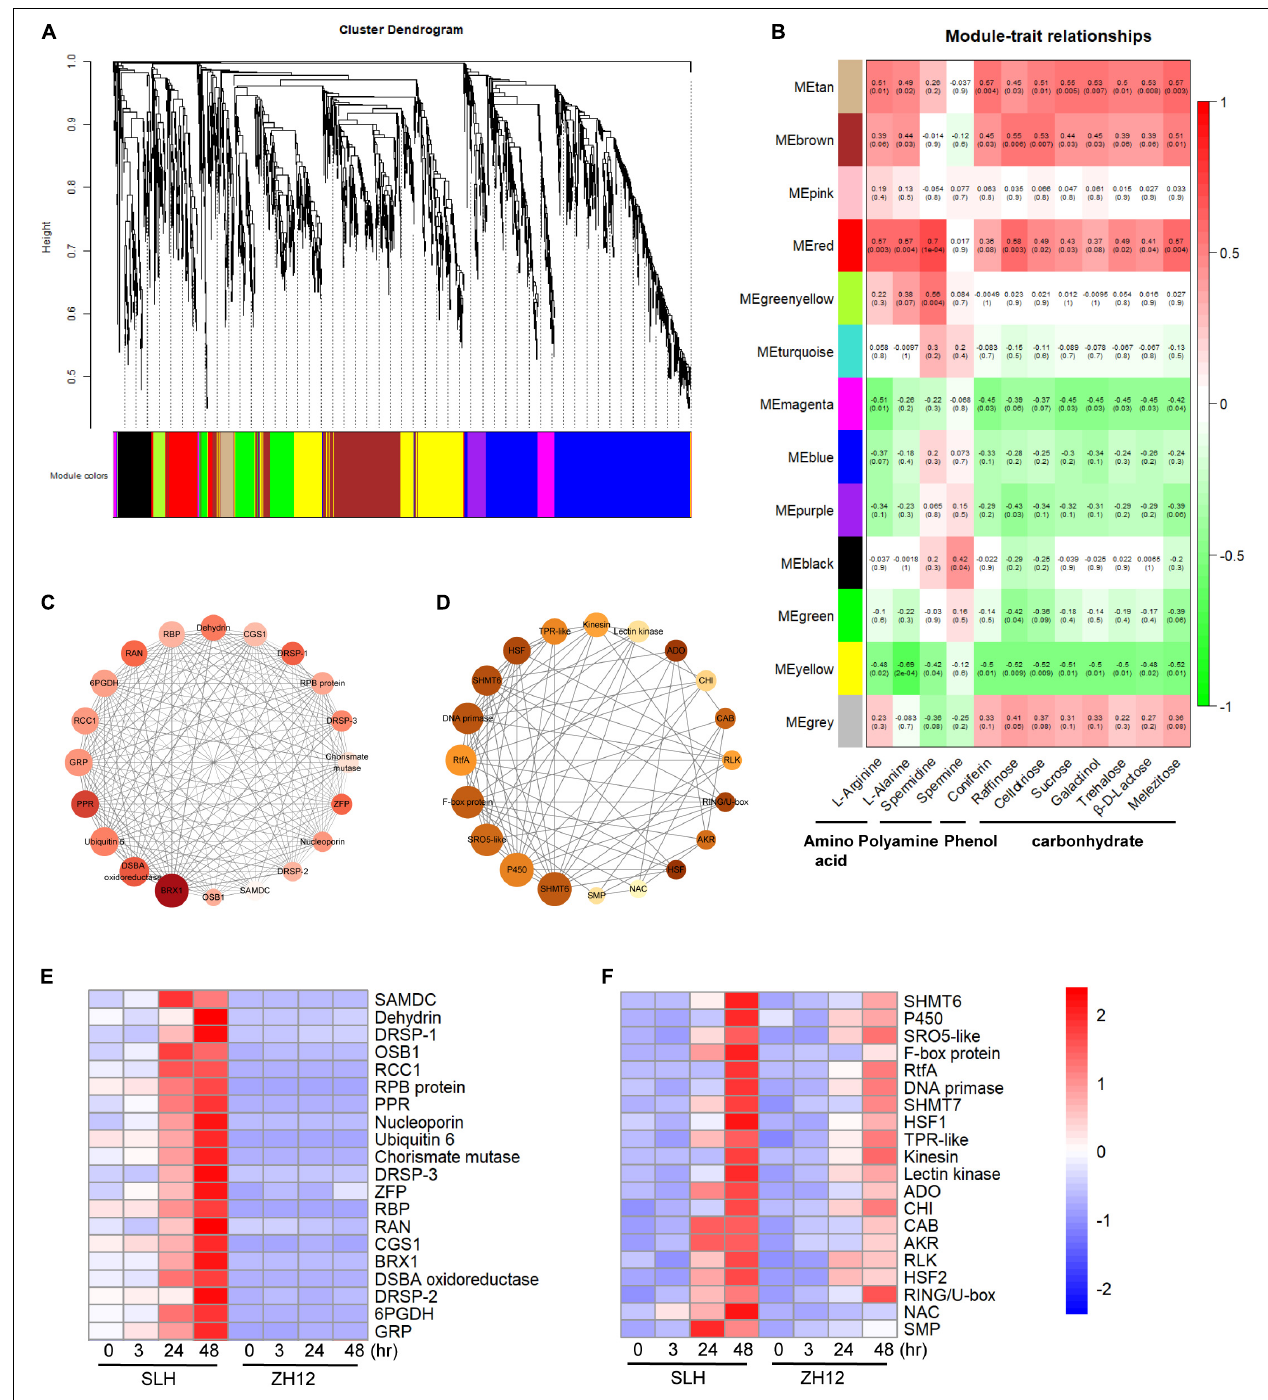
FIGURE 5 | Identification of hub genes and key modules responsive to cold stress in peanut by WGCNA. (A) The hierarchical cluster tree shows 13 modules of co-expressed genes. Different modules are marked with different colors. (B) Correlations of metabolite contents with WGCNA modules. Each row corresponds to a specific module eigengene and a column to a trait. The values in each cell represent the correlation coefficients (r), and the p -values (in parentheses) of the module-trait association. The deeper the red or green in a cell, the higher the positive or negative correlation between the module eigengene and a trait feature. Visualization of the key co-expression network red module (C) and the tan (D) module by Cytoscape. The top 20 hub genes with the highest degree of connection to other genes are shown in the nodes. The color of node corresponds to degree value, and size means module membership value calculated by WGCNA. The darker and larger of the nodes indicates the greater hubness of the gene. Hierarchical cluster analysis of the top 20 hub genes in the red module (E) and the tan (F) module. The values in the heatmap (E,F) represent the z-score of the FPKM (transcript levels) in different samples. Red color indicates a high expression level, while blue is